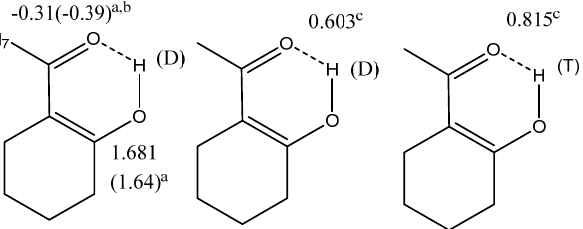
Figure 16. Deuterium isotope effects on chemical shifts in ppm. a. The values in brackets are for 2-acetylcyclohexanone. b. From Ref. [98]. c. From Ref. [99].